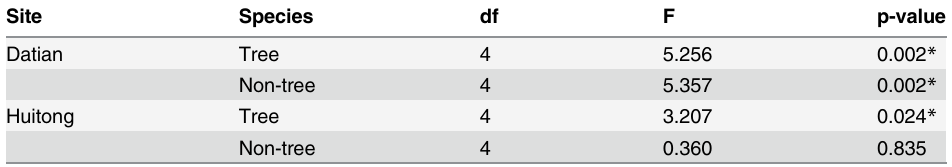
* Denotes signi fi cance of differences between mean